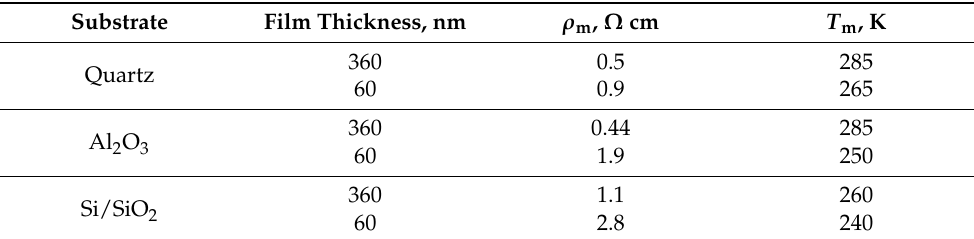
Figure 8. Resistivity vs. temperature dependences of LSMO films with different thicknesses (60 nm and 360 nm) grown on different substrates: quartz, Al 2 O 3 , and Si/SiO 2 . The error bar shows scatter of the results of several samples fabricated from the same film. Table 1. T m and ρ m values for thick (360 nm) and thin (60 nm) LSMO films grown on different substrates: quartz, Al 2 O 3 and Si/SiO 2 .